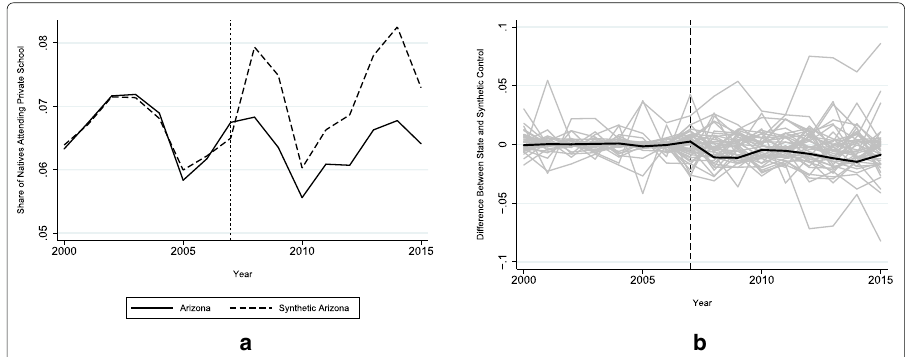
Fig.15 Shareofnativesinsecondaryeducationattendingprivateschool. a Shareofnative. b